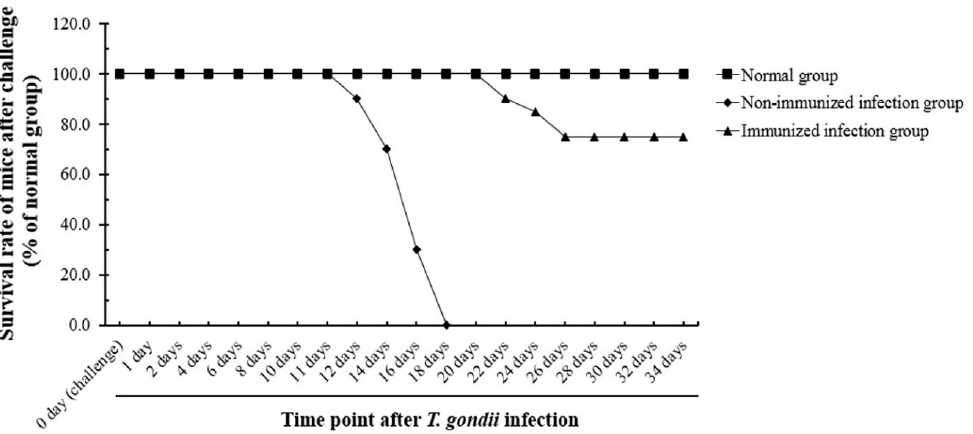
Figure 10. The survival rate of mice after T. gondii infection. The groups were observed daily for 35 days after T. gondii infection (challenge). The non-immunized group all died within 18 days after the parasite infection, whereas the group immunized with SAG1-VLPs showed a survival rate of 75%. The groups were divided into three groups as follows: the normal group, the non-immunized group infected with T. gondii (the non-immunized infection group), and the T. gondii infection group immunized with SAG1-VLPs (the immunized infection group).